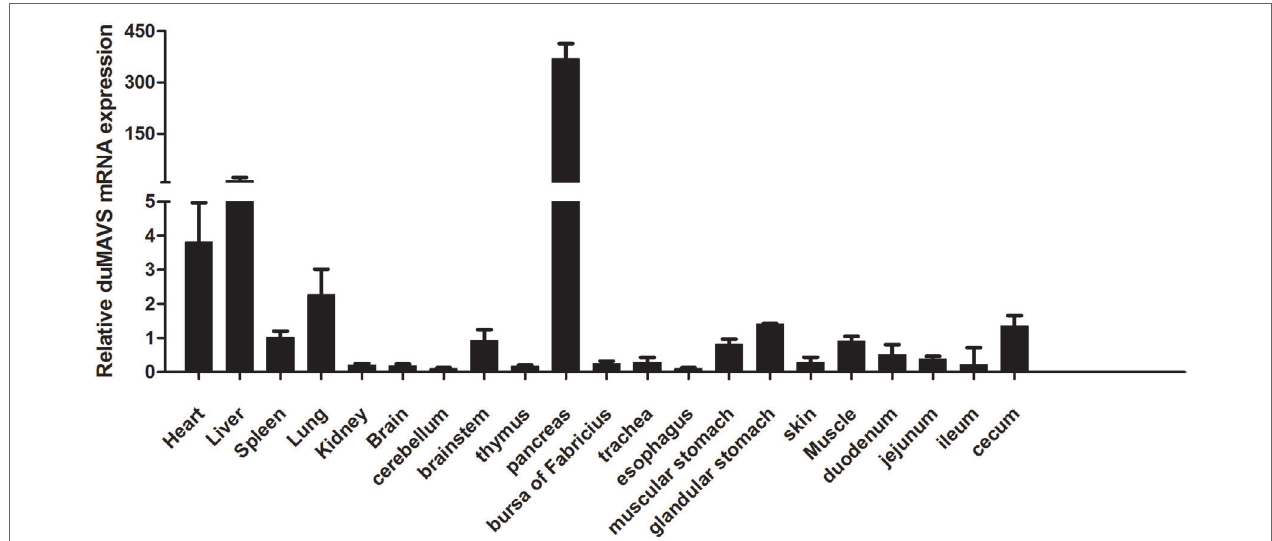
FigUre 2 | The result of tissue distribution of duMaVs transcripts in the healthy cherry Valley ducks . The relative mRNA levels were normalized to the expression of the β -actin gene from various tissues. The data were normalized to the spleen and error bars indicated the